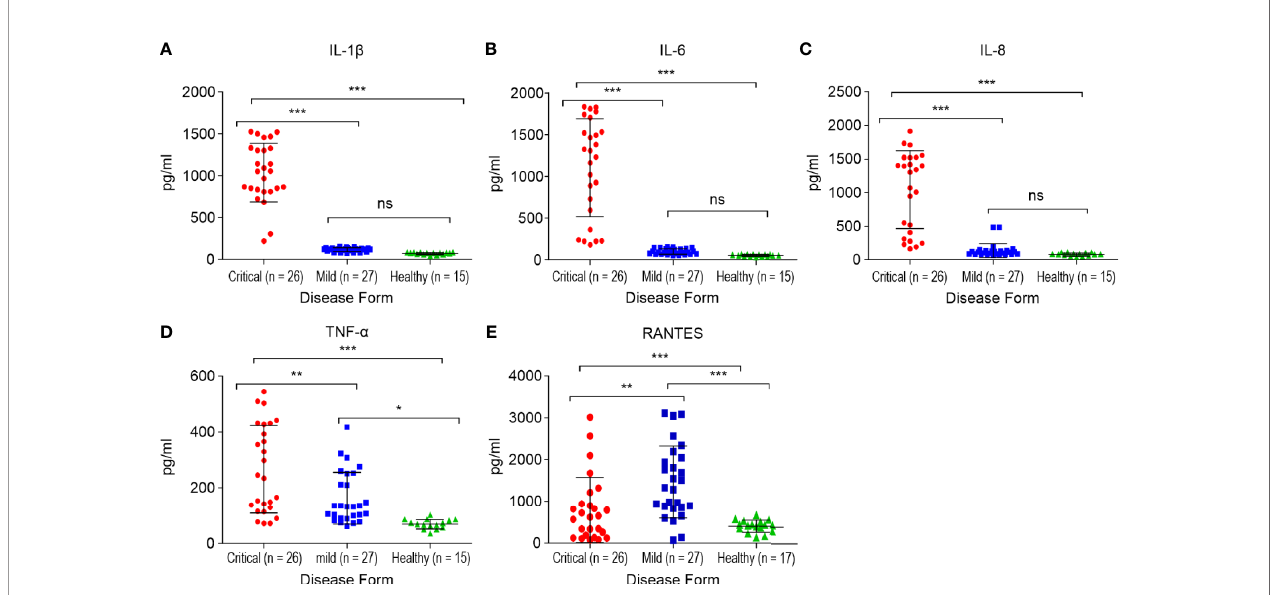
FIGURE 4 | Comparison of the cytokine/chemokine levels between the critical and mild COVID-19 patients, and healthy controls. (A) interleukin 1 b (IL-1 b ); (B) interleukin 6 (IL-6); (C) interleukin 8 (IL-8); (D) tumor necrosis factor a (TNF- a ); (E) RANTES. * p < 0.05, ** p < 0.01 and *** p < 0.001 and ns p > 0.05.